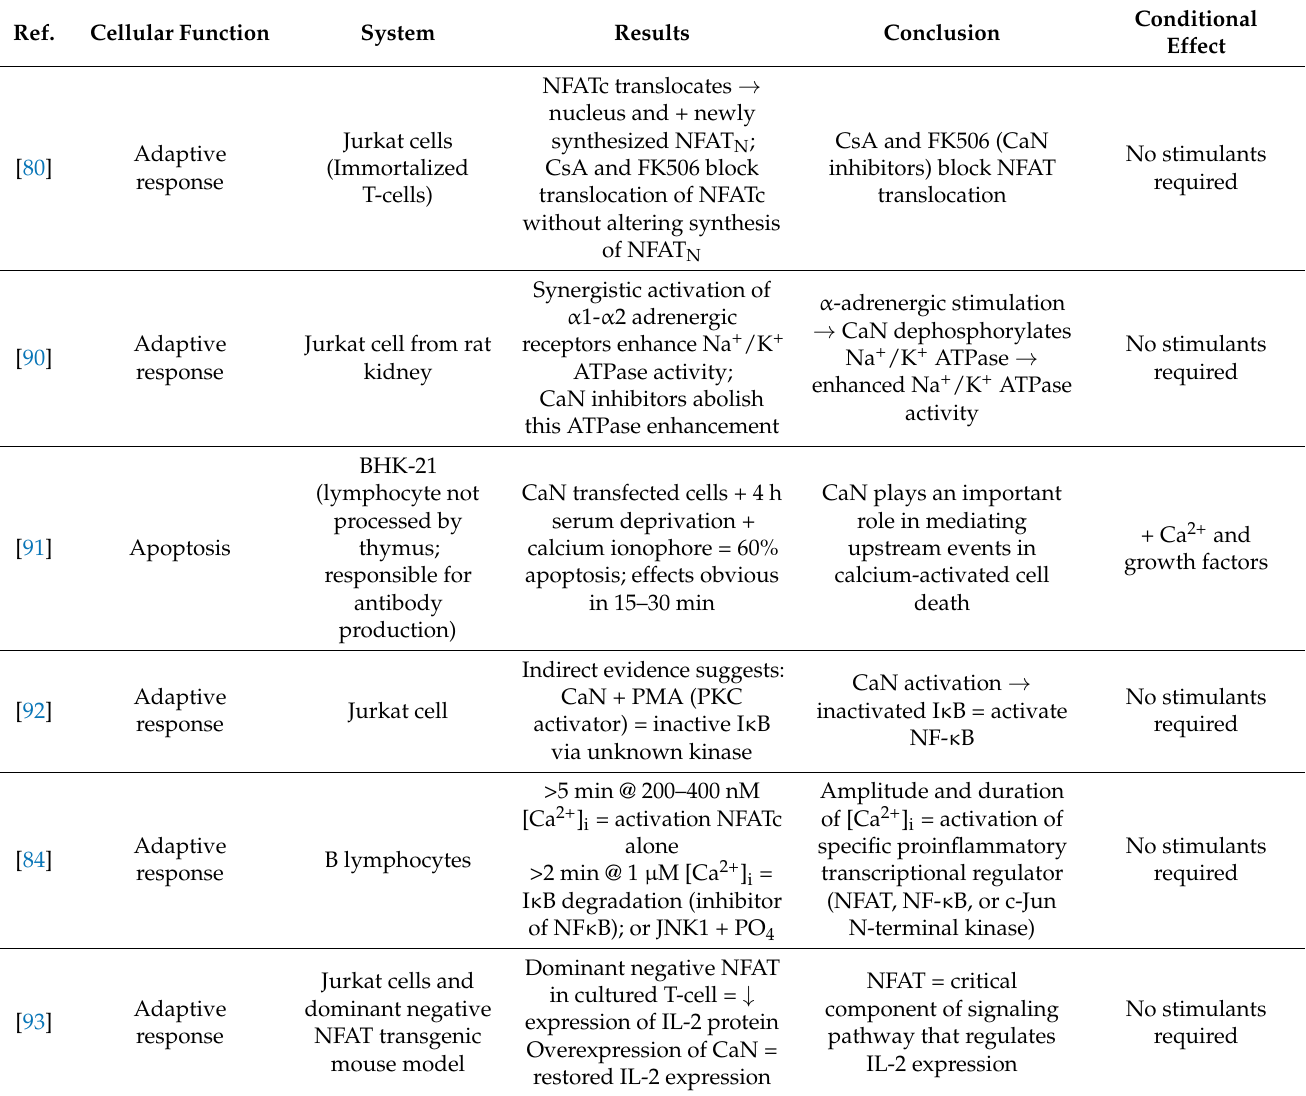
Table 2. An overview of the roles calcineurin plays in cellular physiology.